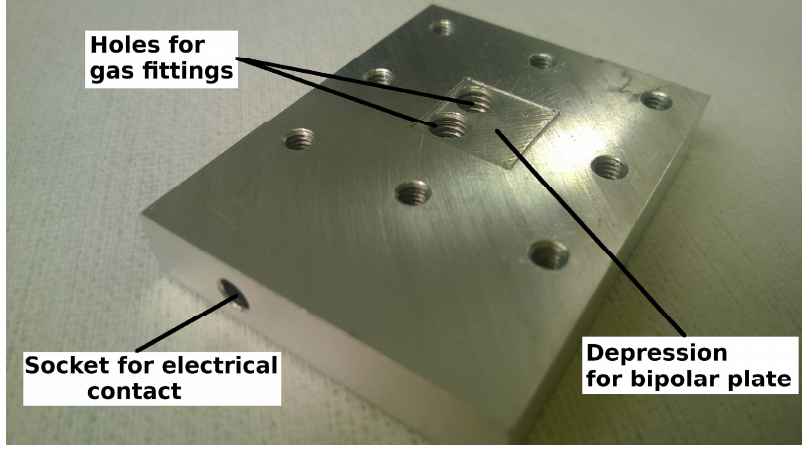
Figure 6. An aluminum block, part of the stack measurement fixture. The jig is comprised of two such blocks.